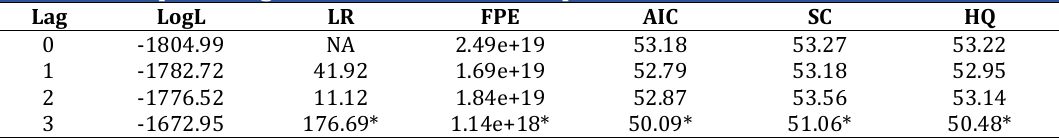
Table 3: The optimal lag selection criteria for the panel VAR model Lag